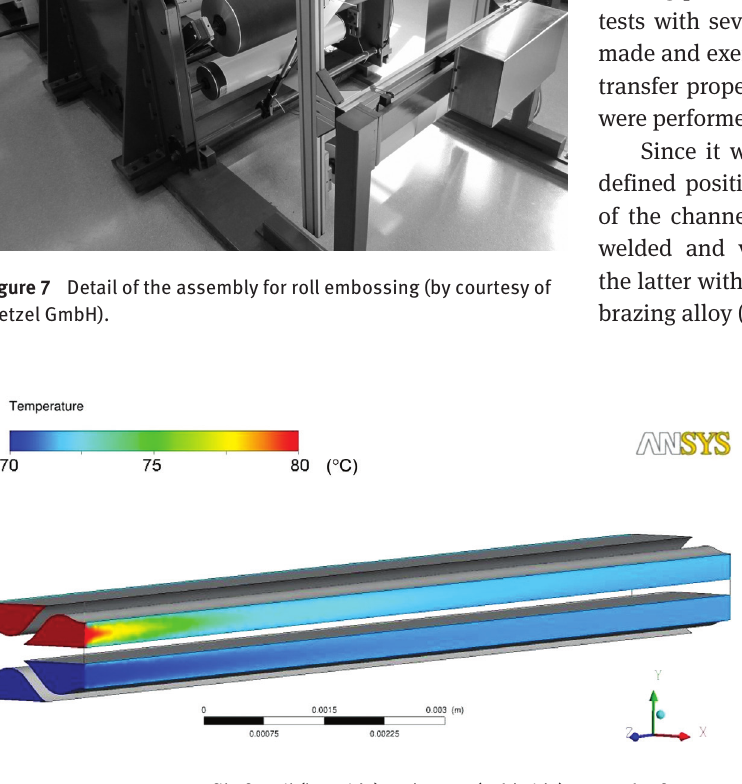
Figure 8 Temperature profile for oil (hot side) and water (cold side) as result of computational fluid dynamics simulation of the reactor’s channel